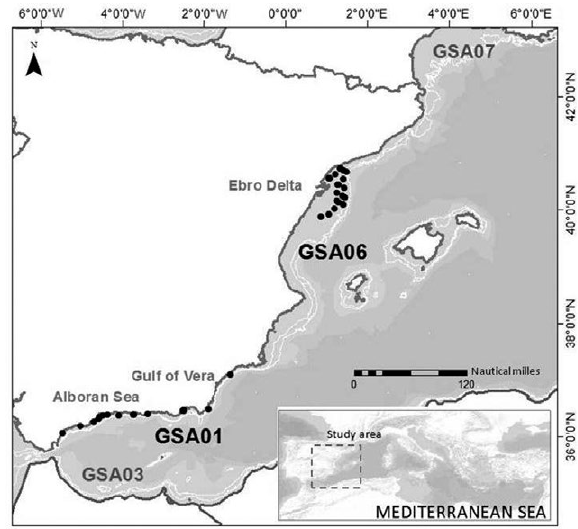
Fig. 1. – Study area. The Spanish Mediterranean Sea zoomed show- ing the sampling stations. General Fisheries Commission for the Mediterranean management units (GSAs) are included: in black the studied GSAs (GSA06, northern Spain, and GSA01, northern Alboran Sea) and in grey the adjacent GSAs (GSA07, Gulf of Lions, and GSA03, southern Alboran Sea). The white lines represent the isobaths between 100 and 200 m, the deepest one being the conti- nental shelf limit.